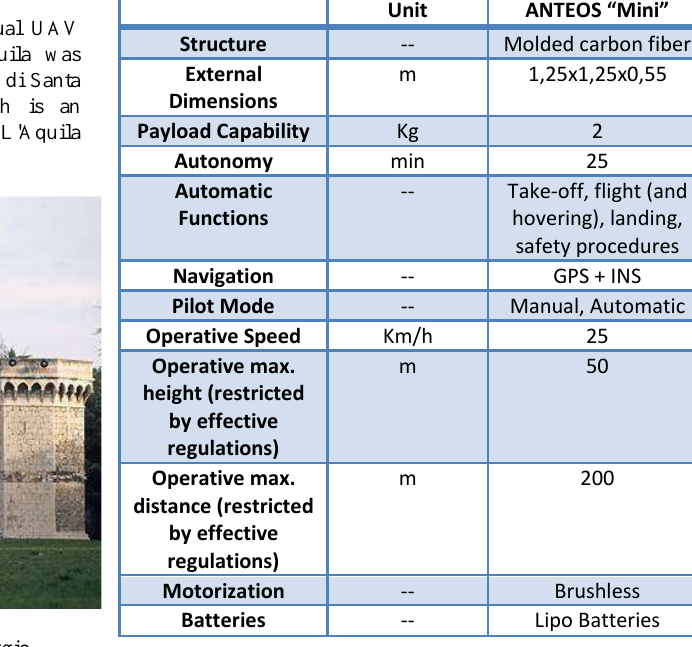
Table 6. Features of the ANTEOS